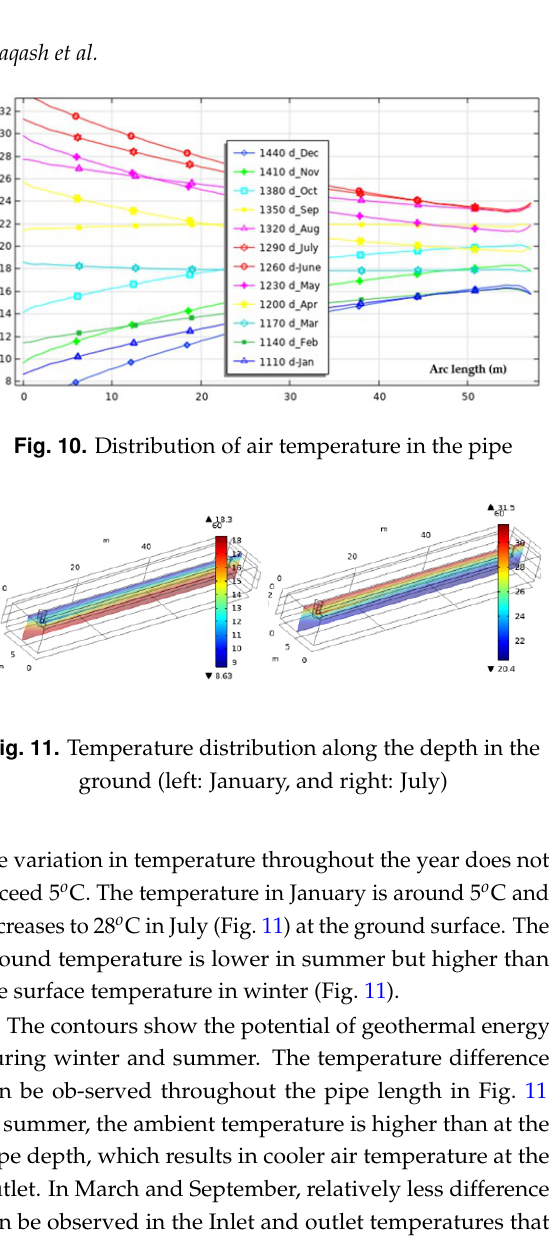
Fig. 11. Temperature distribution along the depth in the ground (left: January, and right: July)